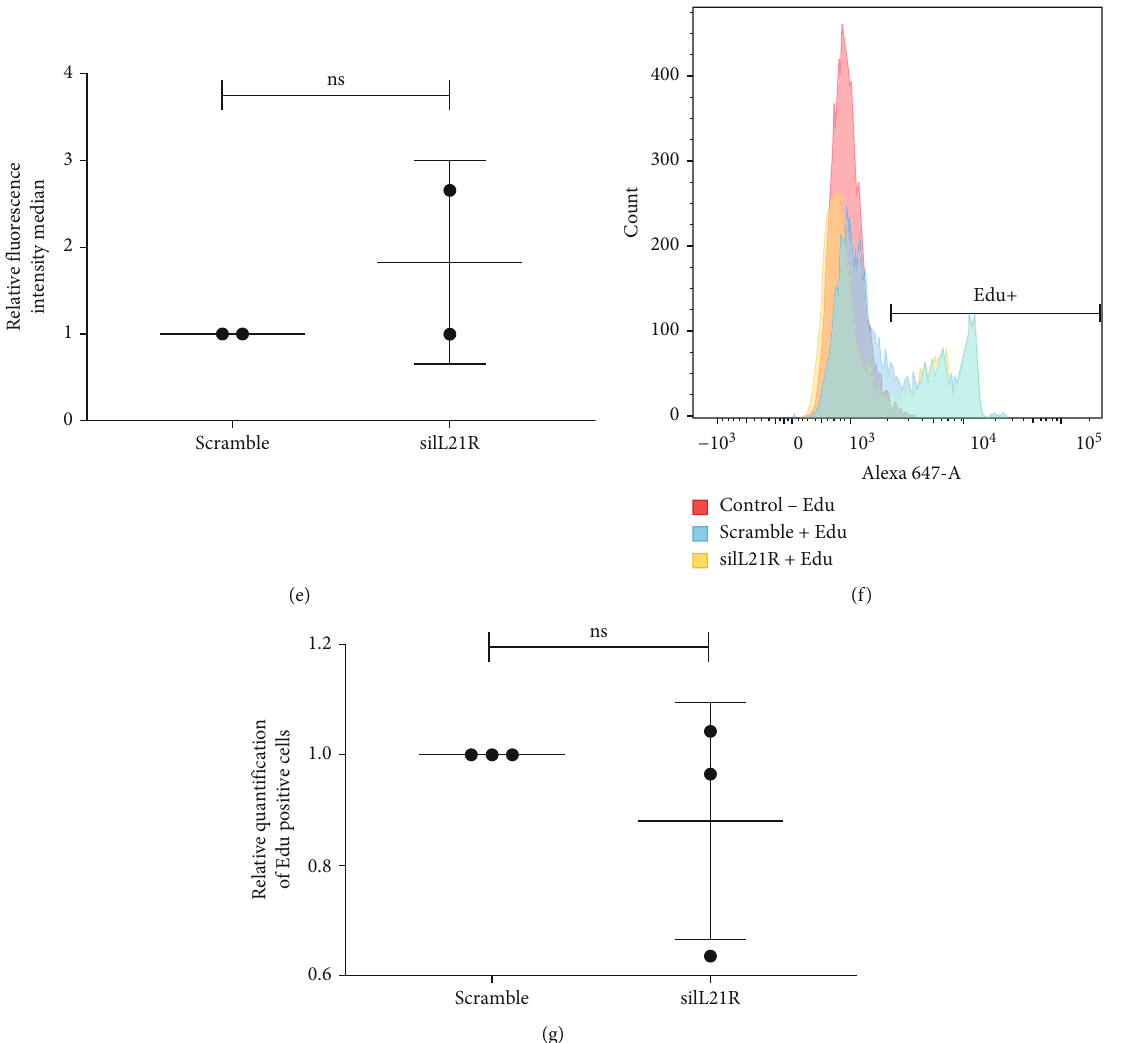
Figure 3: Silencing of the IL21R gene in ADSCs. Cells were transfected with siRNA of IL21R and a siRNA scramble as a control. (a) Relative quanti fi cation of IL21R RNA normalized by GAPDH using qRT-PCR after 24-hour transfection ( n = 3 ) (TAL 22, 27, and 32). (b) Western blot analysis to verify IL21R protein levels ( n = 4 ) (TAL22, 27, 32, and 36). Protein levels of GAPDH were used as a control in the load, representative images of the donor TAL22. (c) Mitochondrial probe JC-10 to measure mitochondrial membrane potential ( ΔΨ ) in ADSCs with gene silencing using IL21R siRNA and scramble as control ( n = 3 ) (TAL23, 27, and 32). The JC-10 fl uorescence ratio at basal ( Δ F ) and uncoupling states ( Δ Fcccp ) was used to measure ΔΨ . (d, e) Rhodamine 123 assay to measure ΔΨ after silencing of IL21R ( n = 3 ) (TAL23, 27, and 32). (d) Representative histogram with mitochondrial activity analysis. Cells without rhodamine (red curve) were used as the negative control. (e) Quanti fi cation of the relative fl uorescence intensity means of rhodamine-stained cells. (f, g) Proliferation analysis using EdU incorporation in ADSCs after siRNA silencing ( n = 3 ) (TAL22, 28, and 32). (f) Representative histogram with proliferation analysis using EdU incorporation. Cells without EdU (red curve) were used as a negative control. (g) Percentage of EdU- positive cells. Mean with SEM; Student ’ s unpaired t -test analysis: ∗ p < 0 : 05 , ns: not signi fi di ff erentiation process (3, 7, and 14 days), no di ff erences were found in IL21R expression between noninduced and induced cells.